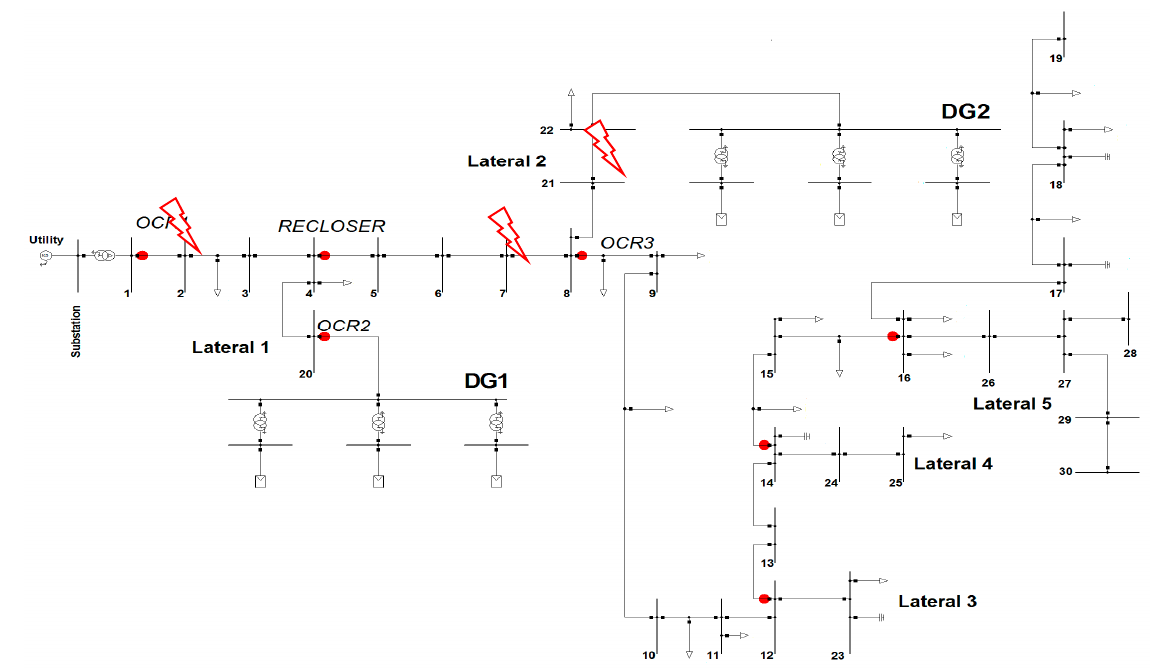
Figure 8. Modified IEEE 34-node test feeder system [34].